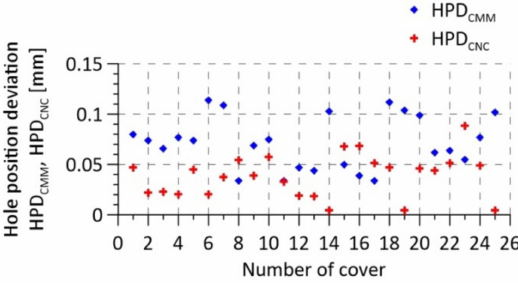
Figure 8. Deviations of the hole position.